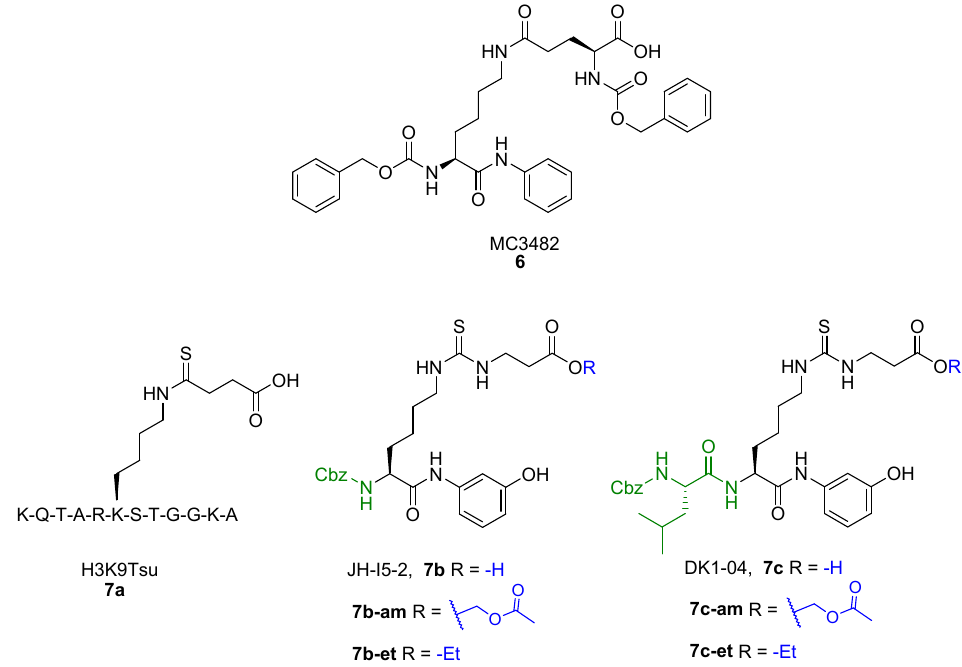
Figure 7. Structures of compounds 6 , 7a , 7b , 7b ‐ am , 7b ‐ et , 7c , 7c ‐ am , and 7c ‐ et .